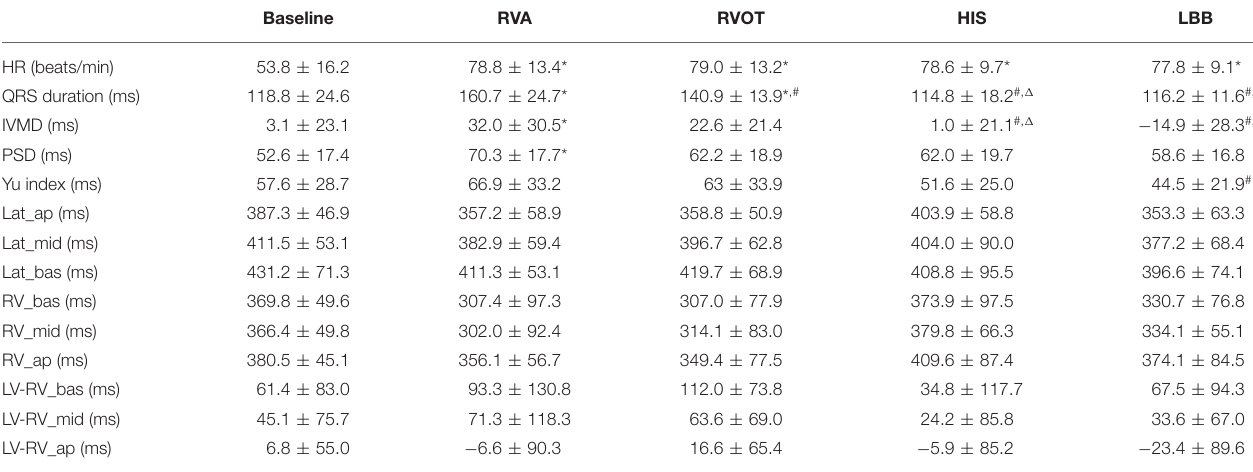
TABLE 3 | Comparison of the acute effect of different pacing sites on cardiac synchrony.